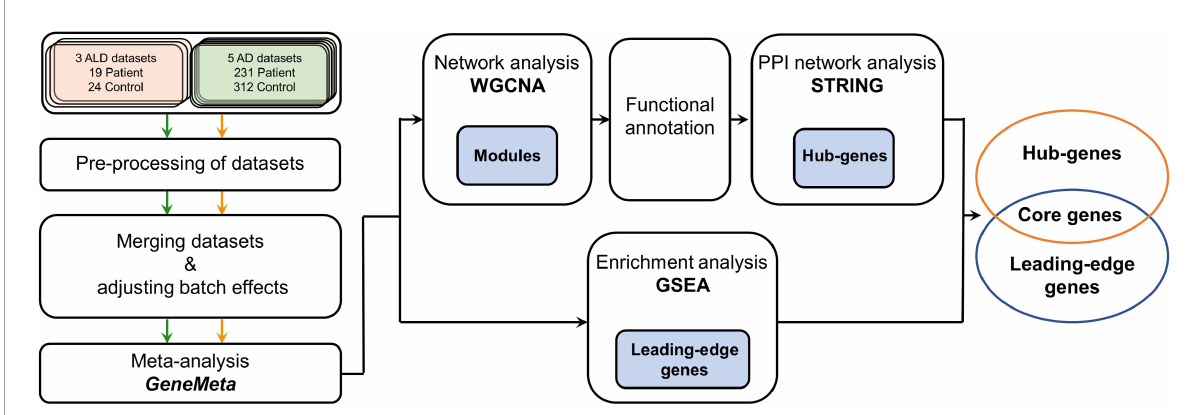
FIGURE1 Workflow of the meta-analysis in this study. Green, orange, and black arrows indicate how cALD, AD, and the meta-analysis datasets were processed, respectively. The meta-analysis using GeneMeta was performed separately for two diseases, but the diseases were later analyzed together in the GSEA, WGCNA, and STRING processes. The blue painted boxes represent genes that were obtained from the corresponding analysis process, and those genes were used in the next analysis process. cALD, cerebral adrenoleukodystrophy; AD, Alzheimer’s disease; GSEA, gene set enrichment analysis; WGCNA, weighted gene co-expression network analysis; STRING, search tool for the retrieval of interacting genes/proteins; PPI, protein–protein